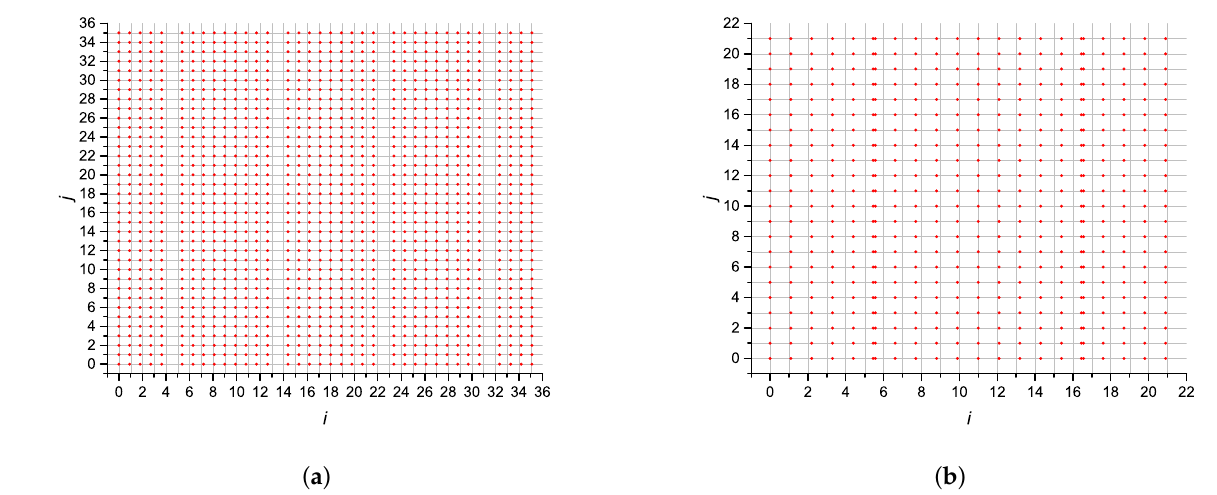
Figure 2. Atomic arrangement of a FM film during tension ( a ) and compression ( b ) of the substrate ( A = 1.0) (undeforming atomic arrangement falls on the intersection of vertical and horizontal grid